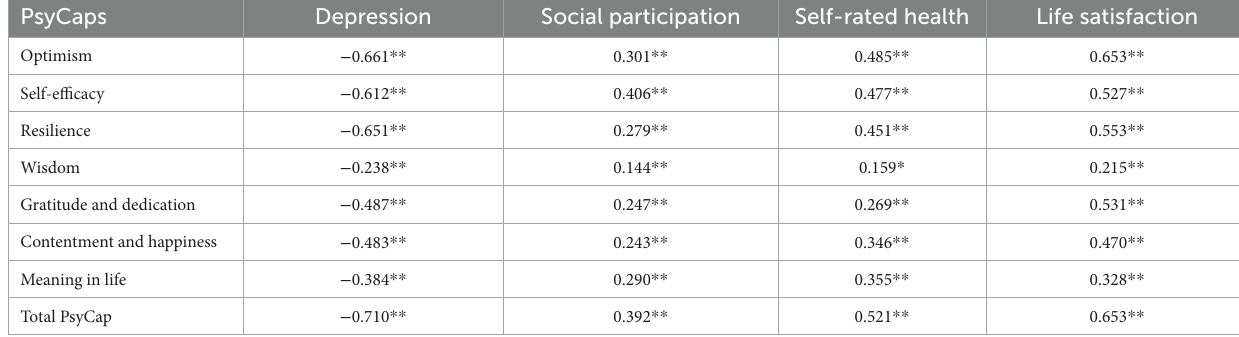
TABLE 7 Results of correlations between PsyCaps and other variables ( N =